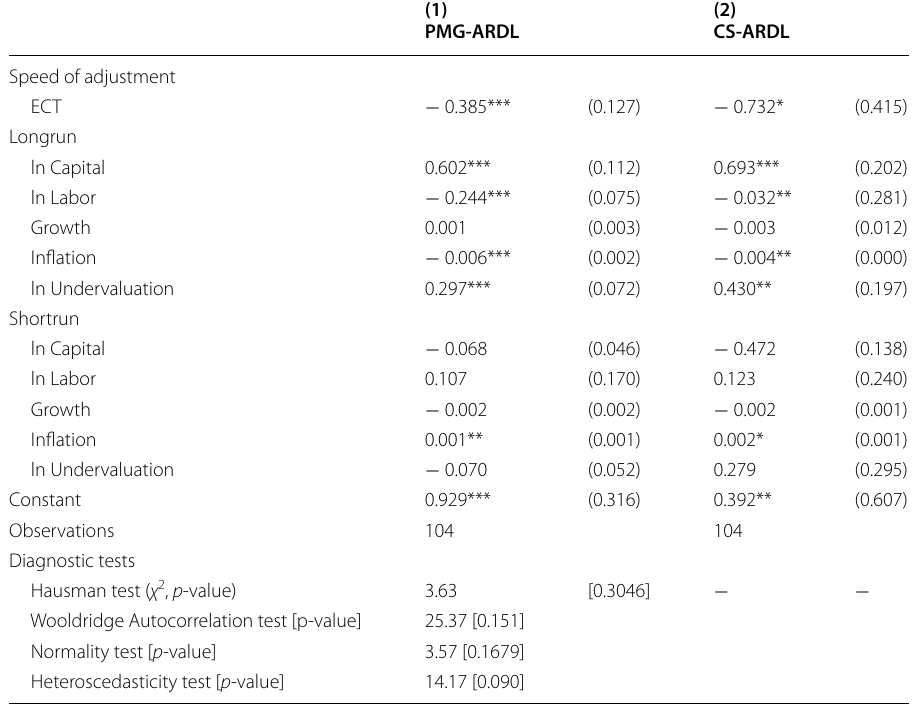
Table 10 Effect of an unadjusted undervaluation measure on service sector. Source: Authors’